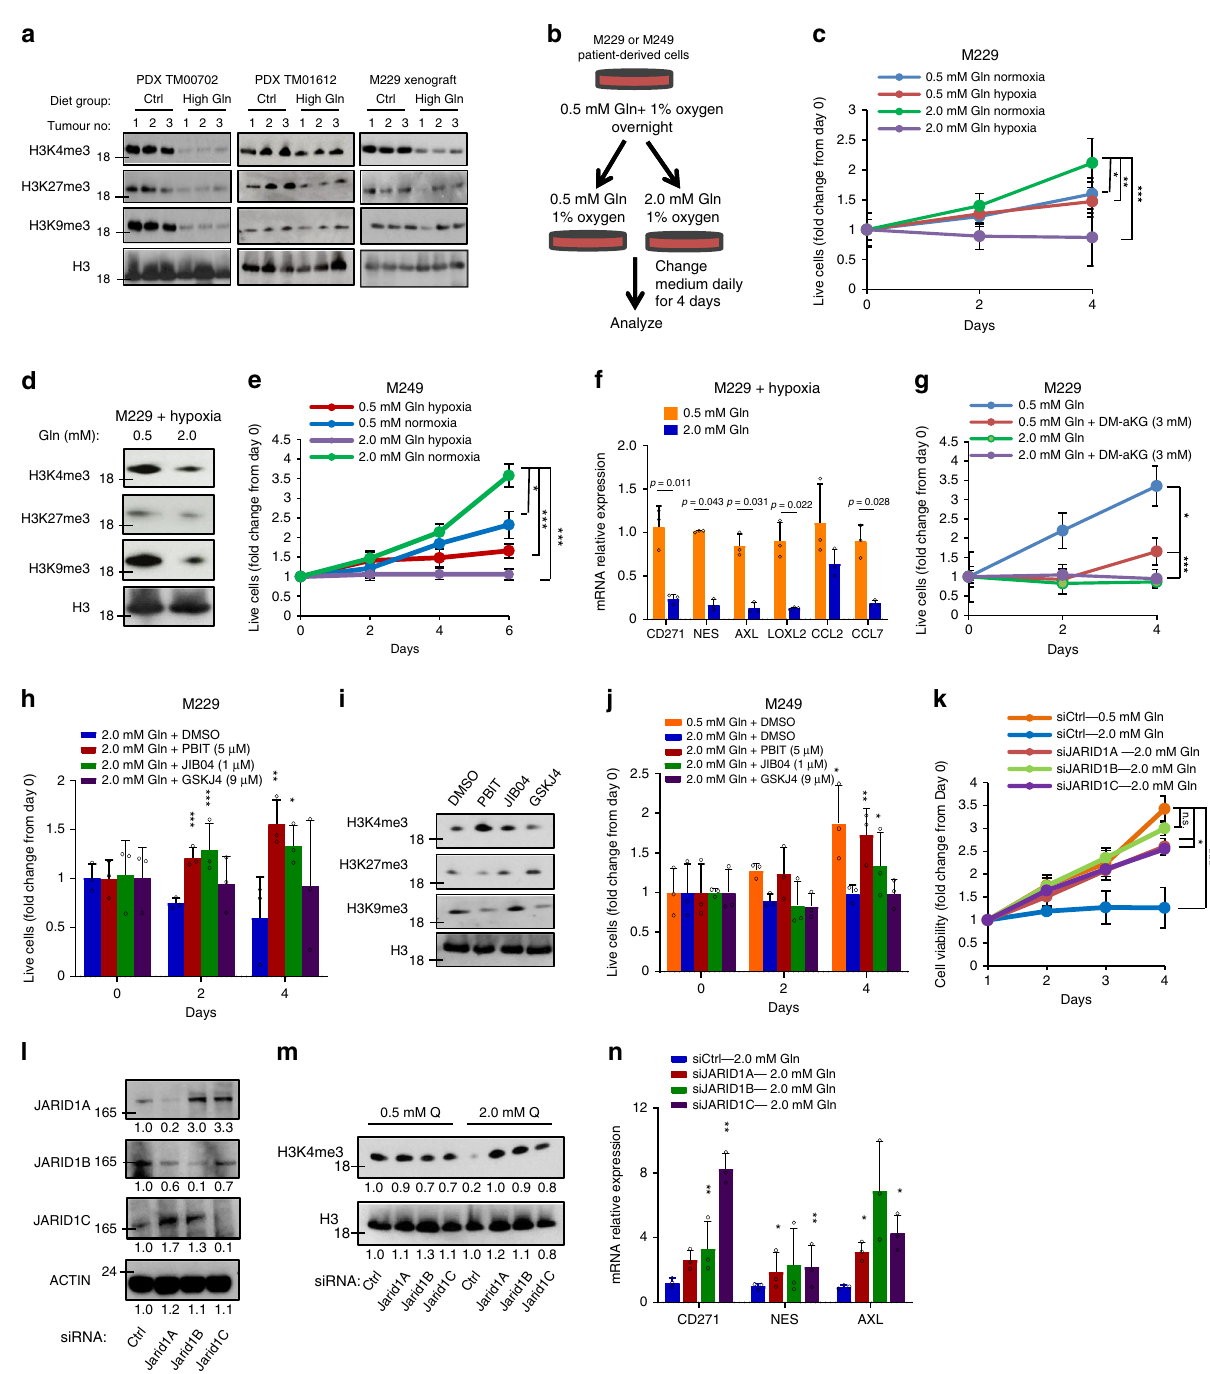
Dietary glutamine supplementation cooperates with targeted therapies . As H3K4me3 is a marker for transcription initiation, we investigated whether downregulation of melanoma genes in tumours was directly linked to decreases in H3K4me3 level. We performed H3K4me3 chromatin immunoprecipitation – sequencing (ChIP-seq) and observed a signi fi cant decrease in overall H3K4me3 mapping near the promoter regions in PDX_TM00702 tumours from mice receiving glutamine supplementation (Fig. 7a and Sup- plementary Fig. 5). GSEA analysis indicated that glutamine sup- plementation affected H3K4me3 enrichment at genes involved in melanoma oncogenic pathways such as AKT and ERK, previously observed by RNA-seq analysis (Fig. 7b). Correlating downregulated